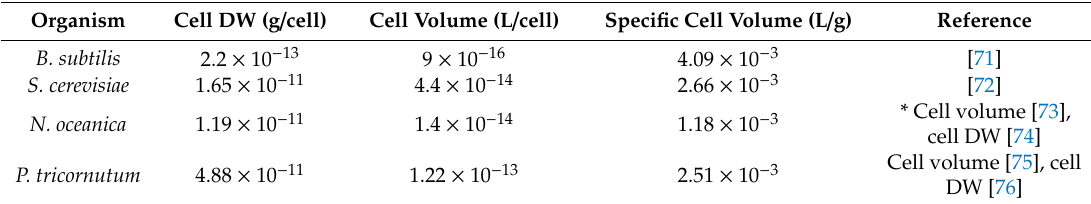
Table 2. Literature values listed for cell dry weight (DW), cell volume, and specific cell volume (L / g) employed to estimate intracellular concentration.